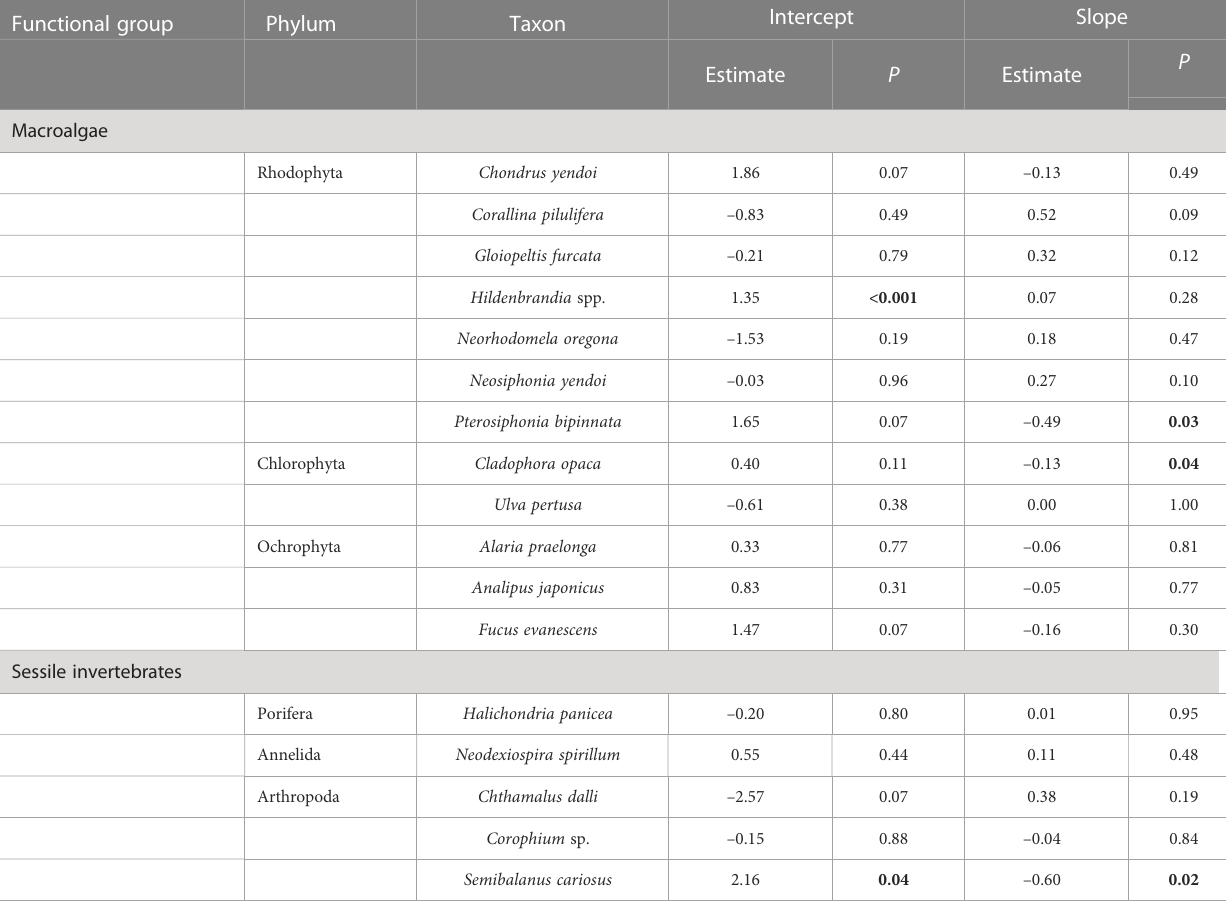
TABLE 1 Accumulative carryover effects of MHWs on the abundances of 17 sessile species. Functional